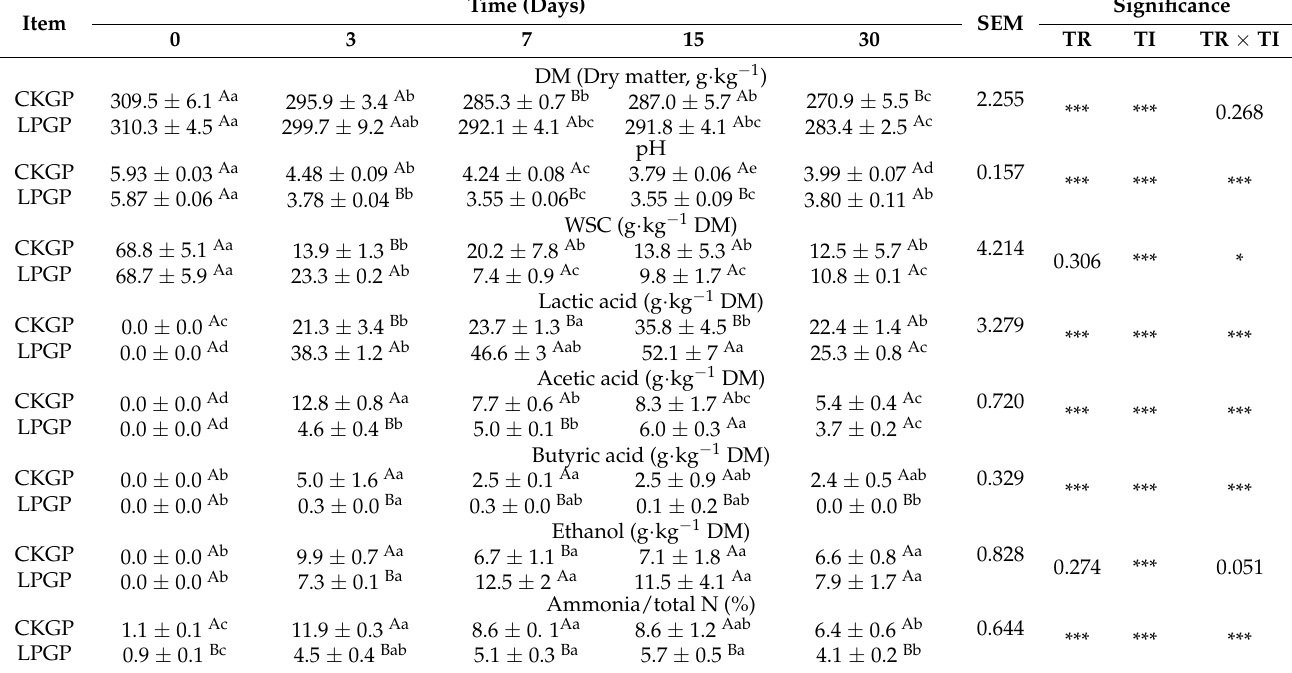
Table 2. Effects of inoculation and fermentation time on fermented characteristics of the silage.